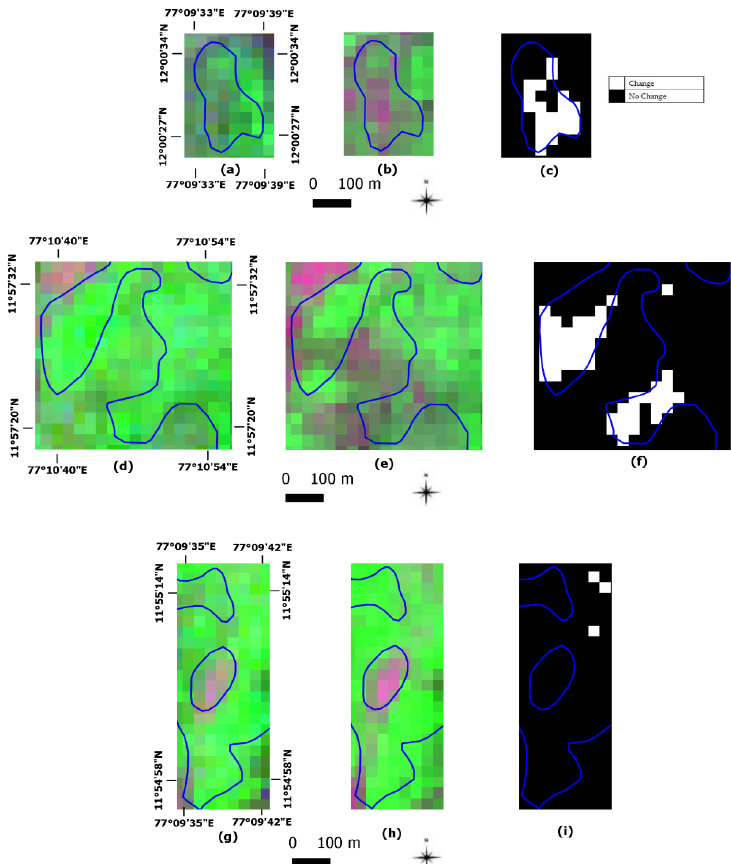
Figure 10 Figure 10. Experiment 1—DIFF_NDVI_HR close-up areas from Figure 9, Indian site: ( a – c ) area close-ups in Figure 9c, red circle, where a new road is present at T 2 in the evergreen forest (evidenced by the blue polygon overlaid on the image); ( d – f ) close-up areas in Figure 9c, blue circle; and ( g – i ) close up areas in Figure 9c, yellow circle.